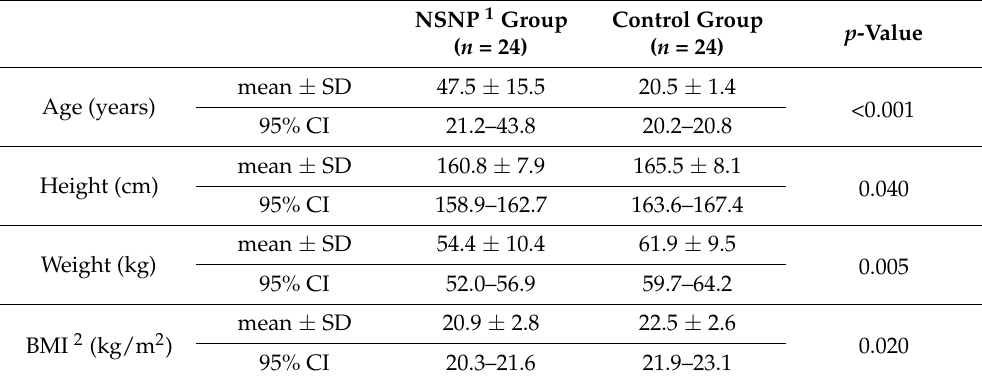
Table 1. Demographic characteristic data of